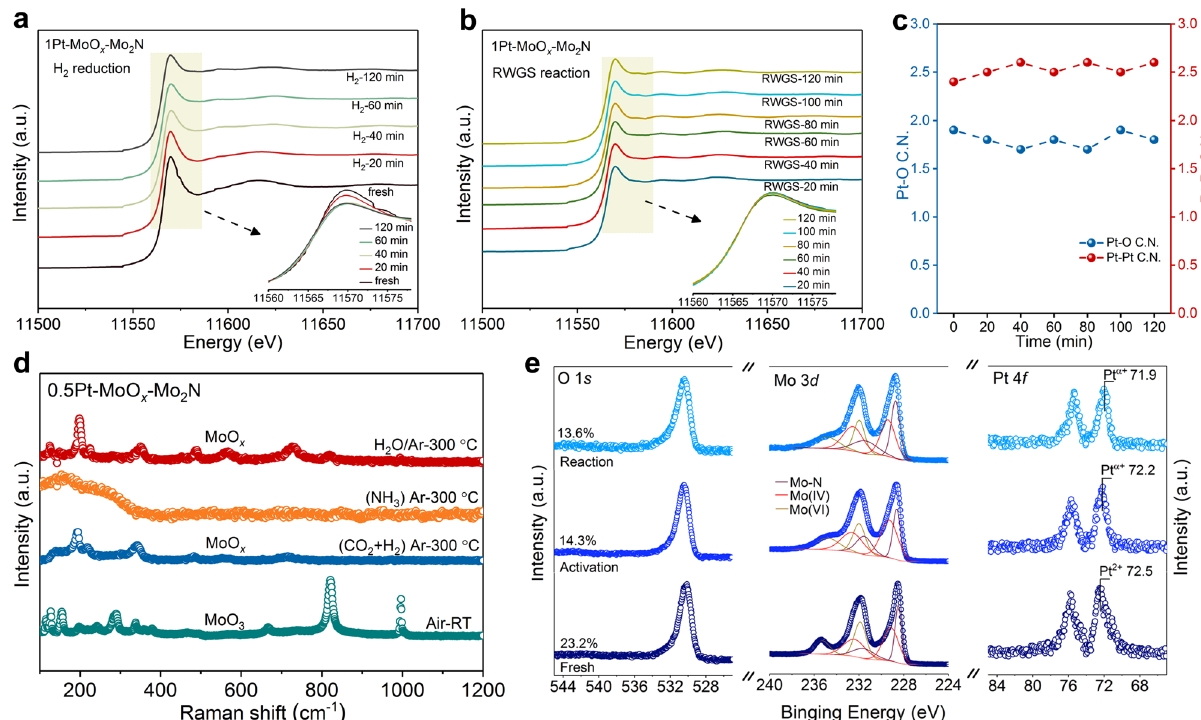
Fig. 3 | Local coordination structure and surface structure of Pt – MoO x /Mo 2 N under H 2 pretreatment and RWGS reaction. In situ XANES pro fi le at Pt L 3 edge under a H 2 pretreatment and b RWGS reaction, respectively. c The change of Pt coordination number during the RWGS reaction. d In situ Raman spectra of